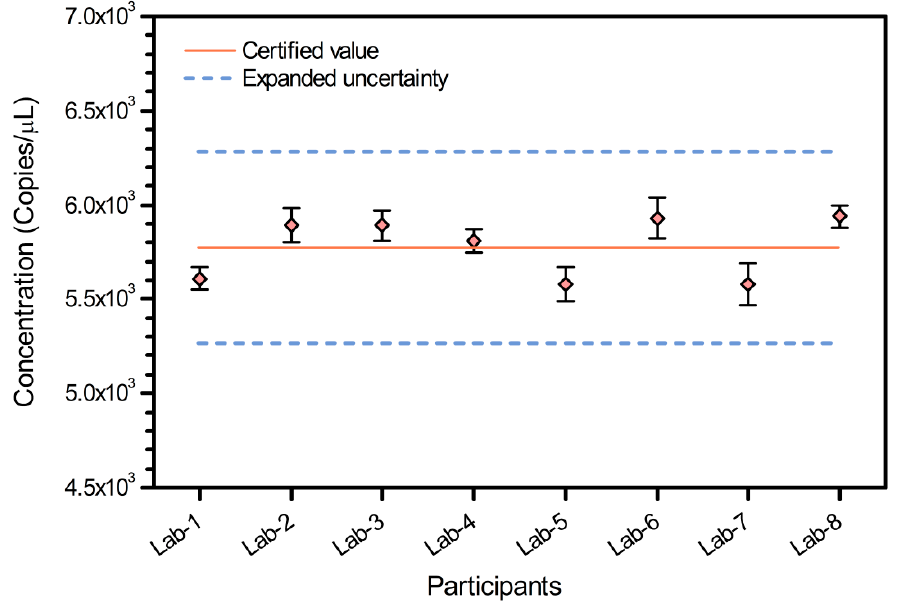
Figure 3. Results for dPCR quantification of the IL2 gene copy number by eight independent participating laboratories. Solid line, average of participant results ( ♦ ); dotted lines, expanded uncertainty of the certified values of the copy number concentration with a 95% level of confidence.